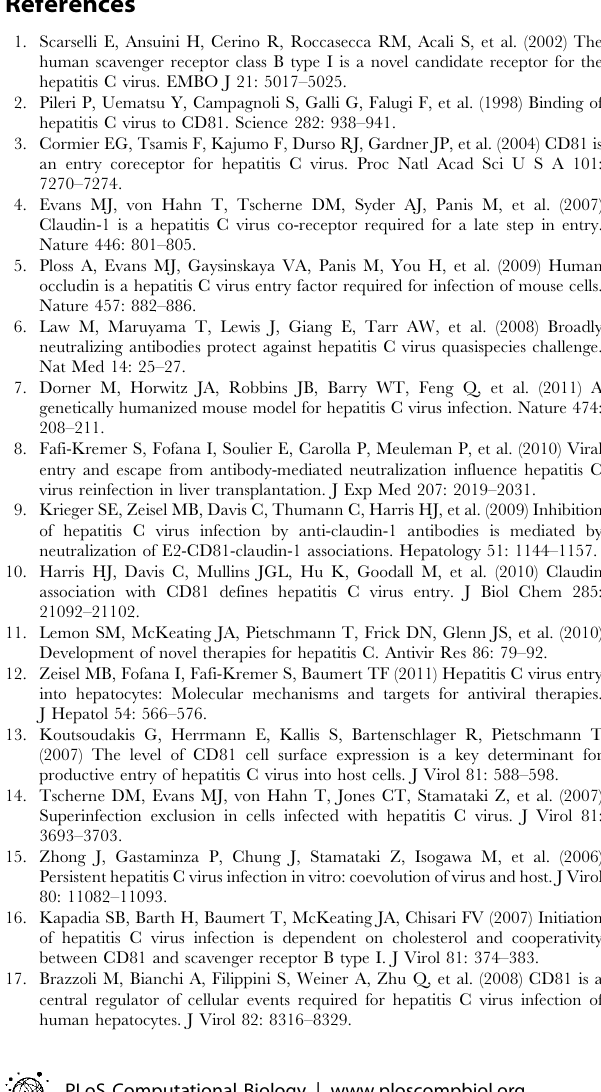
Figure S7 Influence of splitting of cell culture at confluence. Model predictions of the fraction of cells infected without splitting (thick line), splitting at day 6 and day 12 (thin line), and splitting at day 8 and day 12 (dashed line) after the onset of infection compared with the data in Fig. 3D (symbols). Parameters used are the same as in Fig. 3D. Figure S8 Mean number and probability of formation of E2-CD81 complexes. (A) Model predictions of the mean number of E2-CD81 complexes formed, N C , as a function of CD81 expression for K D = 1.7 6 10 2 5 M (solid line), 3.3 6 10 2 5 M (dashed line), 1.7 6 10 2 4 M (dashed-dotted line), and 3.3 6 10 2 4 M (dotted line). (B) Model predictions of the Poisson probability of forming N C E2-CD81 complexes (Eq. (5)) when N C ~ 1 (solid line) and N C ~ 30 (dashed line). Figure S9 Conversion of fluorescence intensity to CD81 expression. Measured distributions of the CD81 expression level on Huh-7.5 (silRR) cells digitized from Zhang et al. (2004) J Virol 78:1448–1445 (diamonds) and Huh-7.5 cells from Koutsoudakis et al. (2007) J Virol 81:588–598 (triangles). Lines are best-fits of the